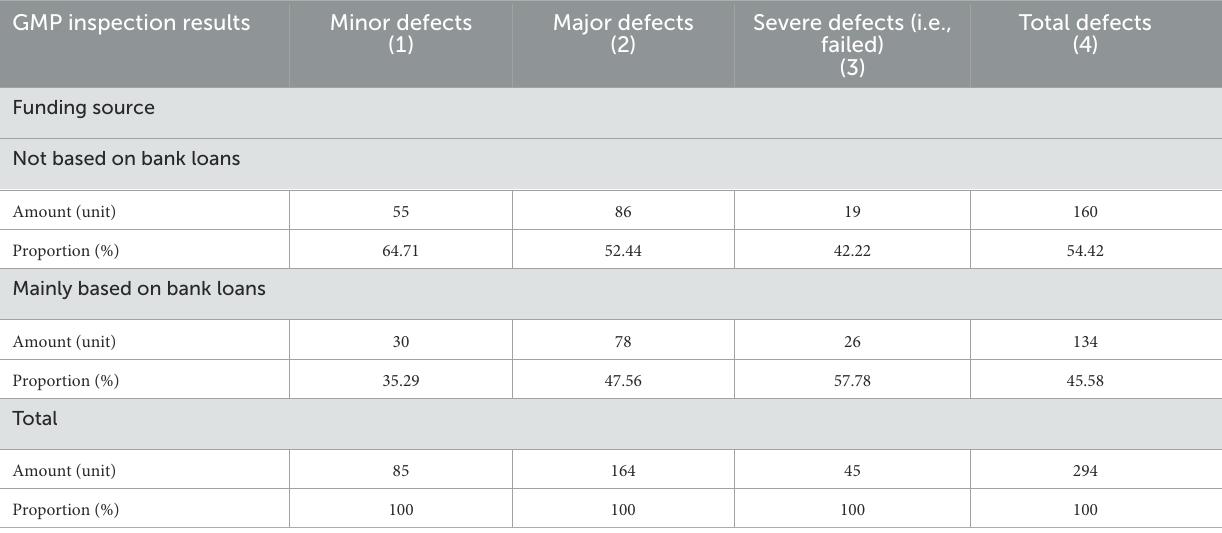
TABLE 2 Comparison of GMP inspection results of the main enterprise whether the source of funds depends on bank